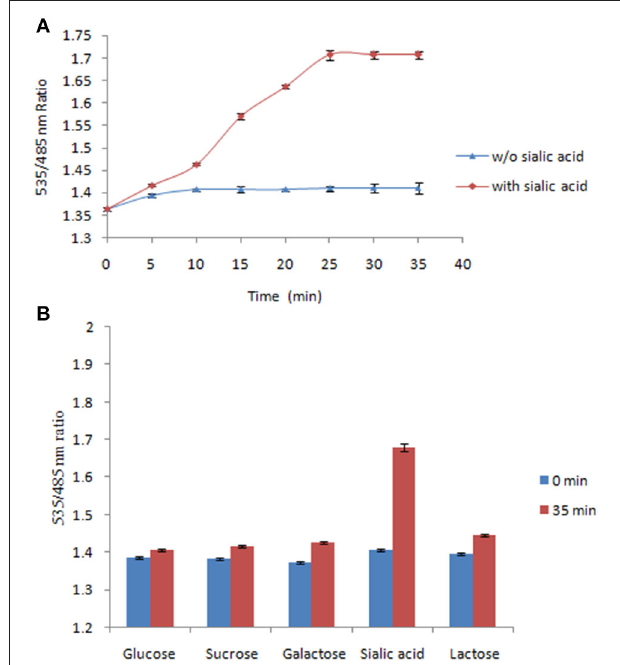
FIGURE 7 | Measurement of NeuAc in bacteria using FLIP-SA. (A) Measurement of NeuAc for 35min after adding 1.0mM NeuAc to bacterial cells expressing FLIP-SA (red circles). Measurement of NeuAc for 35min without adding NeuAc (blue circles). (B) Measurement of the FRET ratio of bacterial cells expressing FLIP-SA after incubation with different sugars at a concentration of 1.0mM for 35min. The data are the average of three replications. Vertical bars show the standard